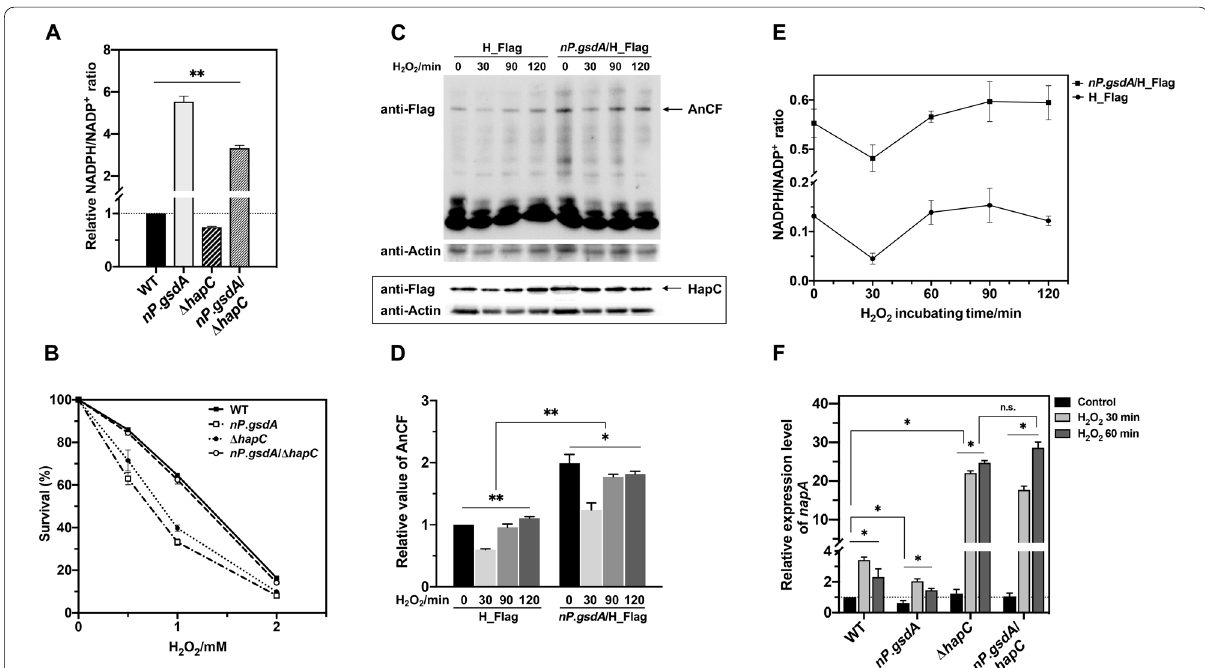
Fig. 5 Intracellular NADPH levels determine the oxidative stress resistance via regulating AnCF complex assembly. A Overexpression of gsdA resulted NADPH accumulation in Δ hapC . WT (WT_ pyrG ), nP . gsdA , ∆ hapC , and nP . gsdA /∆ hapC were cultivated in NO 3 − -MM liquid media for 16 h, then the lysates were used for the relative NADPH/NADP + ratio calculation. NADPH/NADP + value of WT was set to 1 (mean SD; n 3, ** P < 0.01, ± = one-way ANOVA). B AnCF is involved in impairment of H 2 O 2 resistance caused by excess NADPH. Fresh conidia (1 10 8 ) of four strains were spread × on NO 3 − -MM plates containing the indicated concentrations of H 2 O 2 . Colonies were counted after a 48-h incubation, and survival rates were expressed as percentages of the CFU for strains incubated without H 2 O 2 (mean SD; n 3). C Immunoblot quantification of AnCF complex levels ± = (top) and HapC levels (bottom box) in WT and nP . gsdA during H 2 O 2 -treatment; H_Flag (WT expressing Flag-tagged HapC) and nP . gsdA /H_Flag ( nP . gsdA expressing Flag-tagged HapC). Cell-free lysates (100 µg) from each sample were loaded to native- (top) and SDS-PAGE (bottom box). AnCF and HapC were detected using anti-Flag antibody; actin was used as a control and was detected using an anti-Actin antibody. D Quantitated graph for intracellular AnCF level normalized to actin (mean SD; n 3, * P < 0.05, one-way ANOVA). E Time course analysis of NADPH/NADP + level ± = in H_Flag and nP . gsdA /H_Flag during 1 mM H 2 O 2 treatment. Strains were precultivated in NO 3 − -MM liquid media for 16 h and then exposed to 1 mM H 2 O 2 for 30, 60, and 90 min (mean SD; n 3, t -test). F Relative napA mRNA levels in these strains with or without treatment of H 2 O 2 . Strains ± = were cultivated in NO 3 − -MM liquid media for 16 h, and then treated by H 2 O 2 for 30 min and 60 min (mean SD; n 3, * P < 0.05, ** P < 0.01, n.s . , not ± = significant, two-way